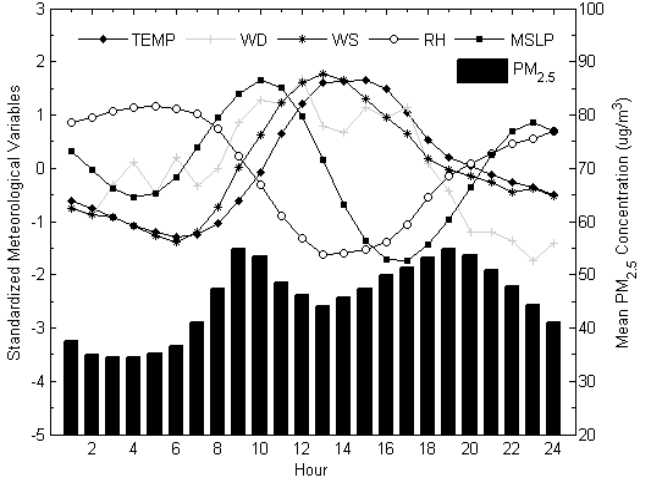
concentrations and meteorological 2.5